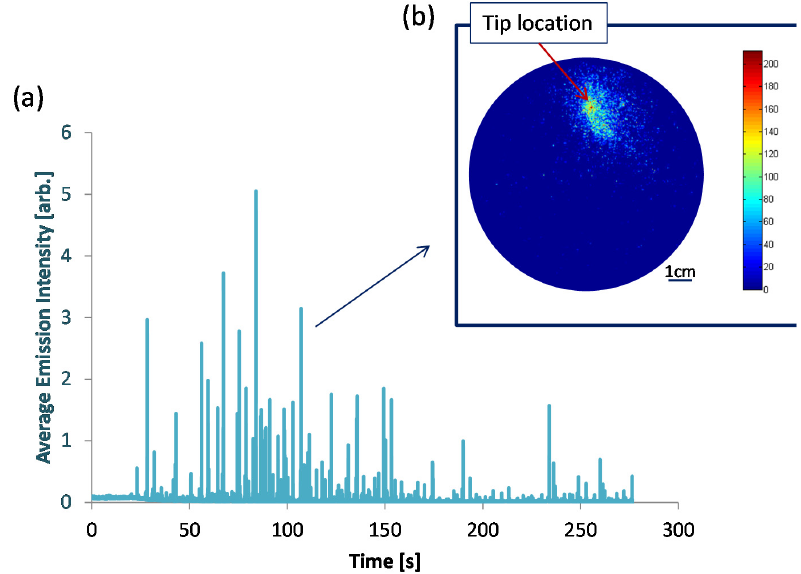
Figure 2. ( a ) Average Emission Intensity (spatial average of each phosphor screen image) vs. time, (complete test); ( b ) Phosphor screen intensity of a single emission event.